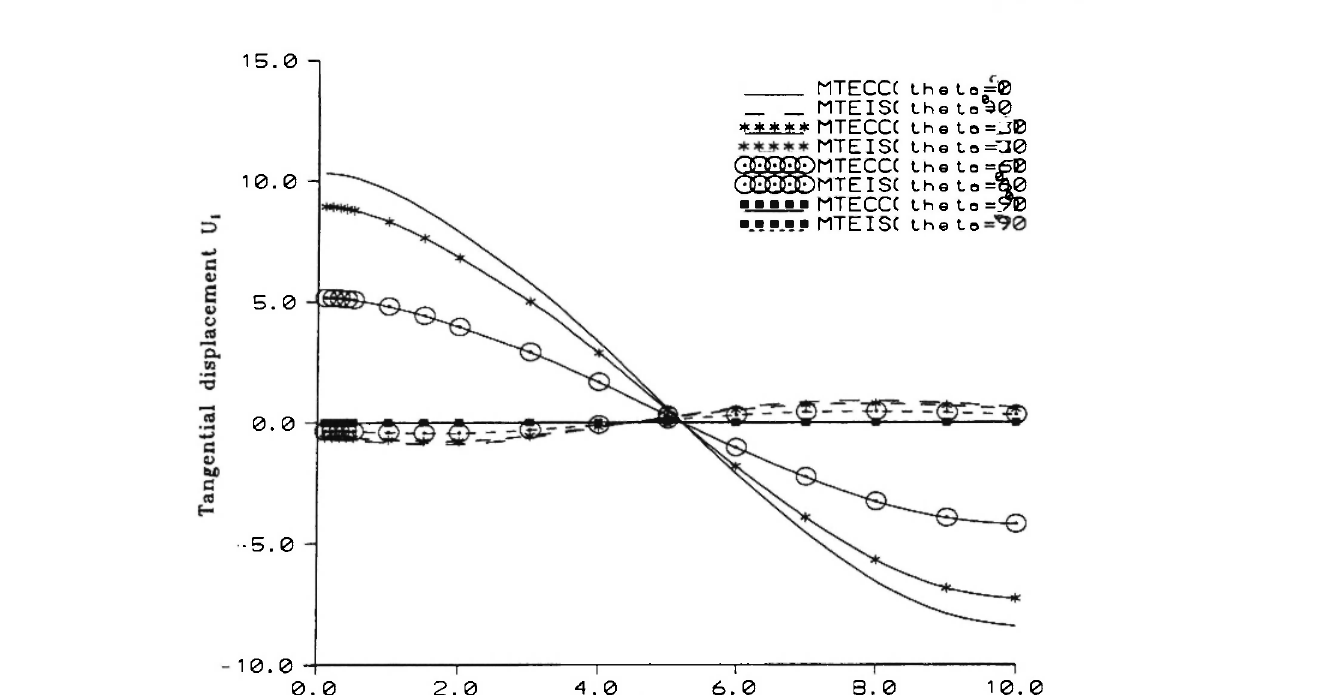
Fig. 3: Variation of Tangential displacement Ui (=Ui /F 0 ) with distance x. (Insulated boundary)